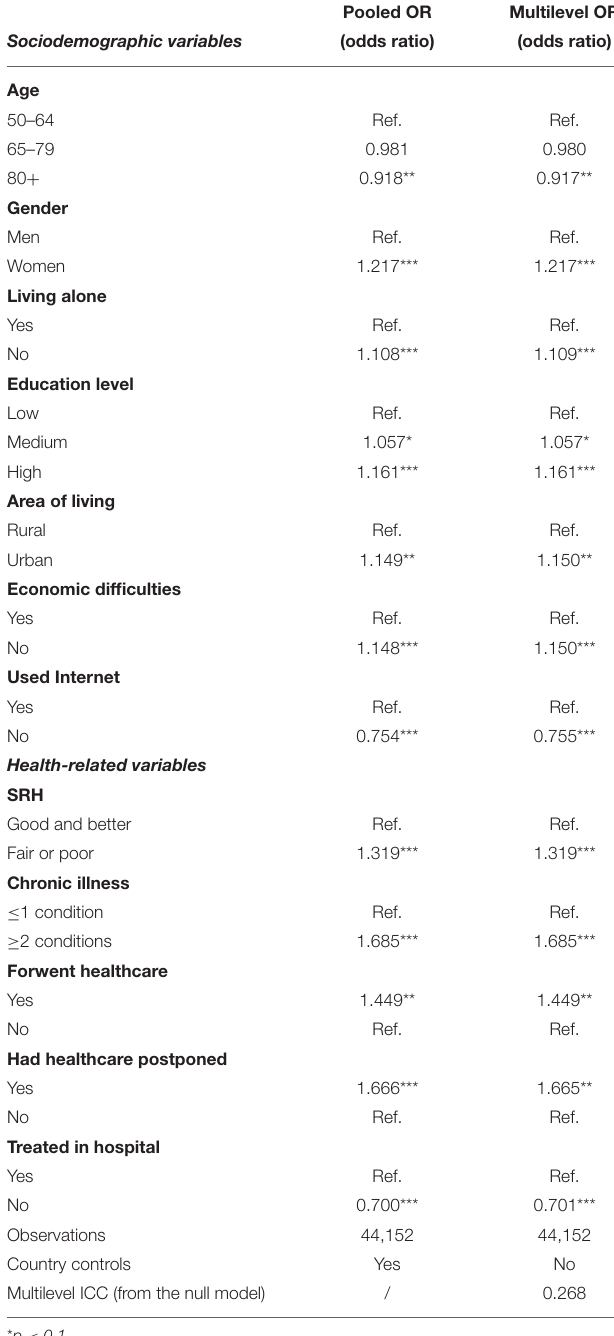
TABLE 4 | Determinants of remote medical consultations among older adults in Europe and Israel after the outbreak of the COVID-19 pandemic. Pooled